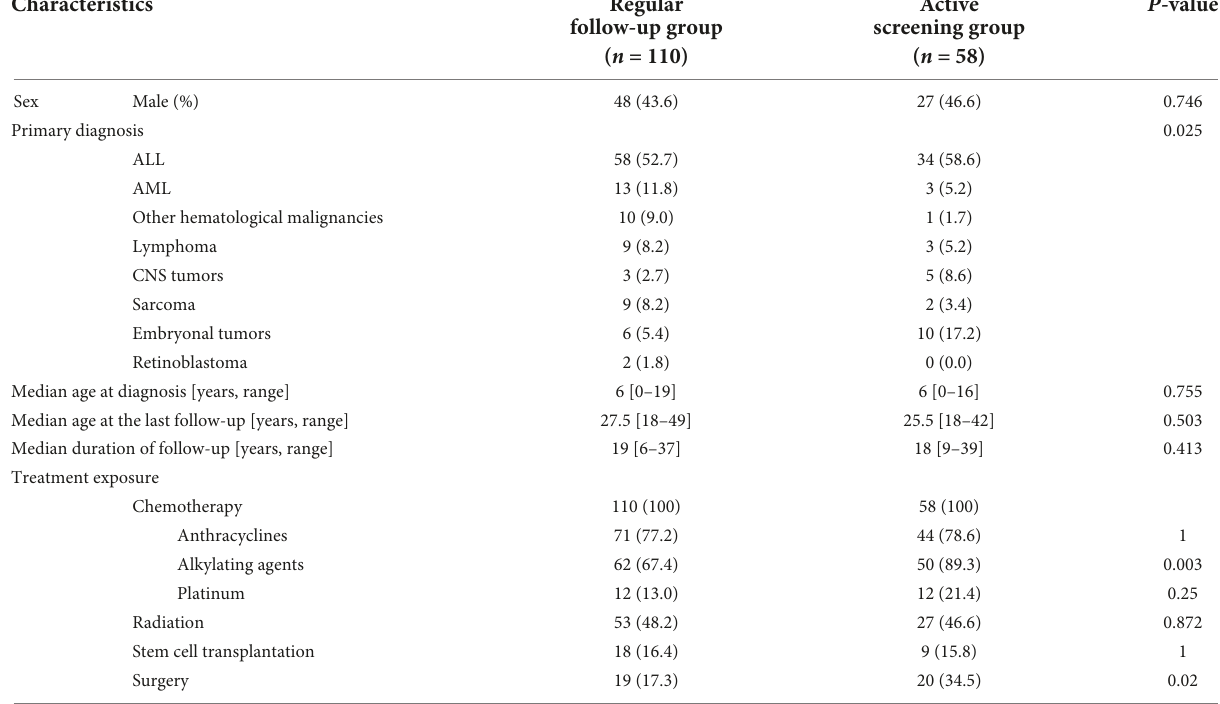
TABLE 2 Demographic, treatment, and diagnostic characteristics of CCSs in the regular follow-up group ( n = 110) and the active screening group ( n = 58). Characteristics Regular